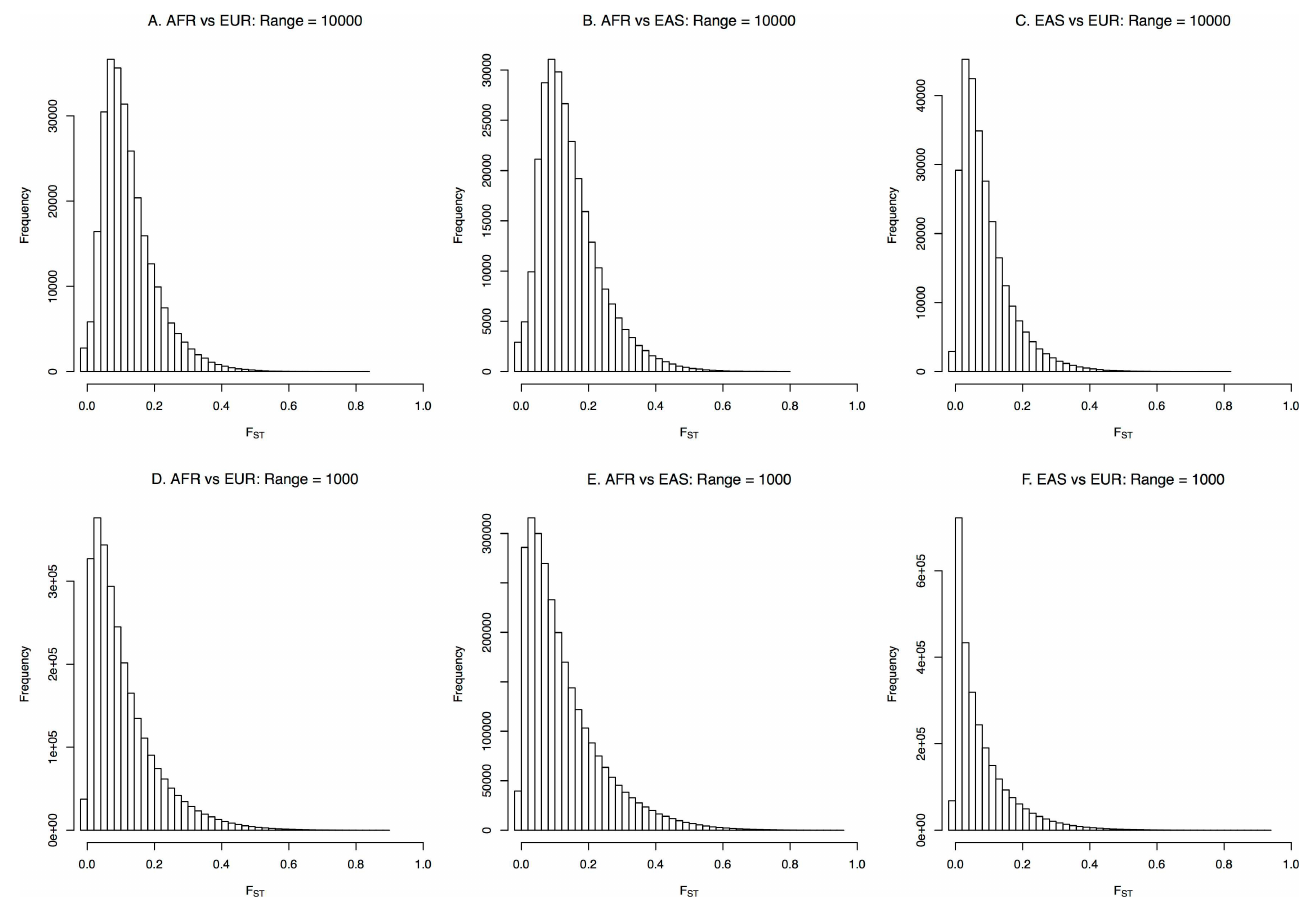
Fig 1. Distributionof genome-wide F ST estimates: (a) AFR vs EUR for the 10,000bp range; (b) AFR vs EAS for the 10,000 bp range; (c) EAS vs EUR for the 10,000bp range; (d) AFR vs EUR for the 1,000 bp range; (e) AFR vs EAS for the 1,000 bp range; (f) EAS vs EUR for the 1,000 bp range.